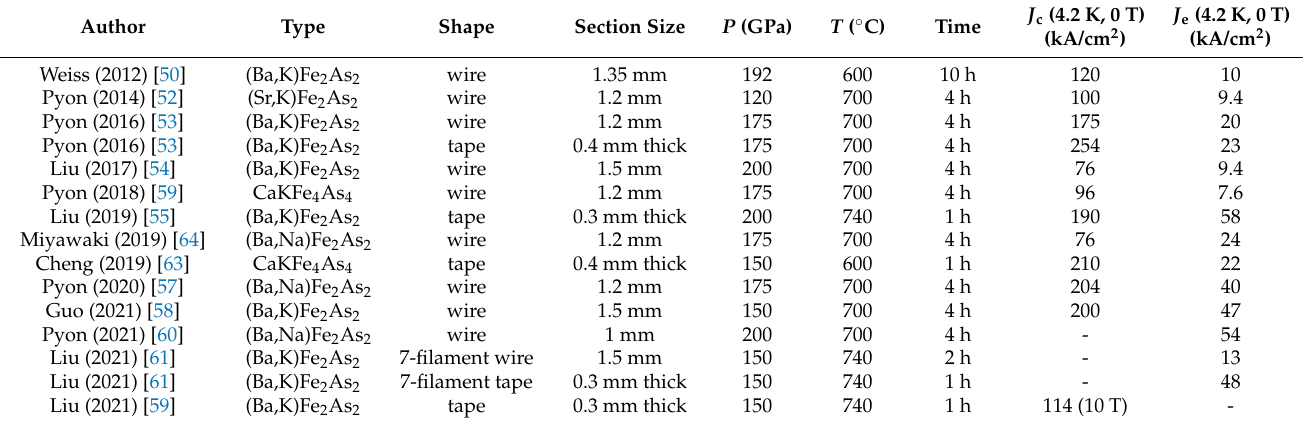
Table 4. Parameters of iron-based wires and tapes fabricated using the HIP